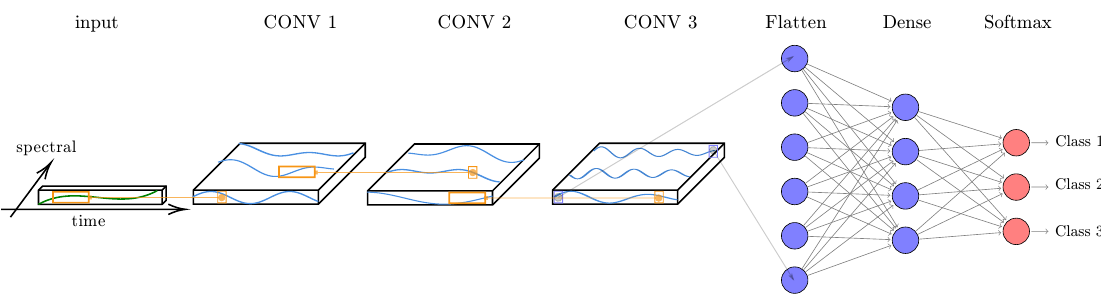
Figure 4. Proposed temporal Convolutional Neural Network (TempCNN). The network input is a multi-variate time series. Three convolutional filters are consecutively applied, then one dense layer, and finally the Softmax layer, that provides the predicting class